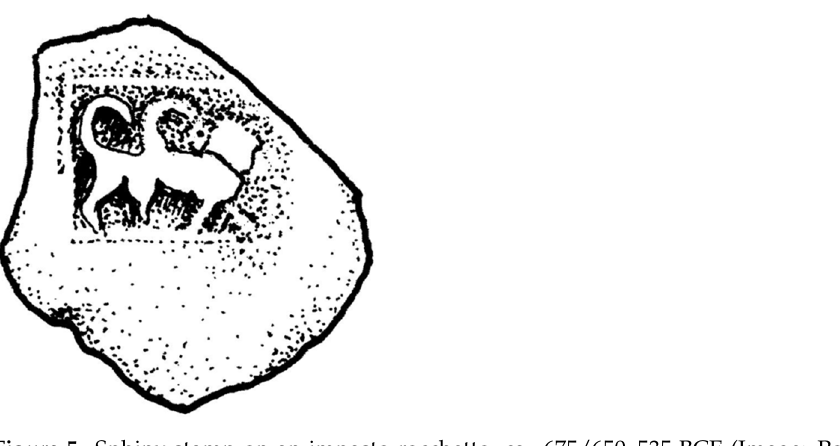
Figure 5. Sphinx stamp on an impasto rocchetto, ca. 675/650-535 BCE (Image: Poggio Civitate Pro- ject).